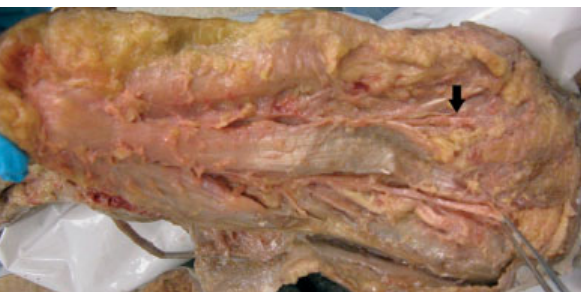
Fig. 1 Foot plantar dissection with forceps holding medial plantar nerve and arrow marking lateral plantar nerve. Nerve stimulation performed at arrow